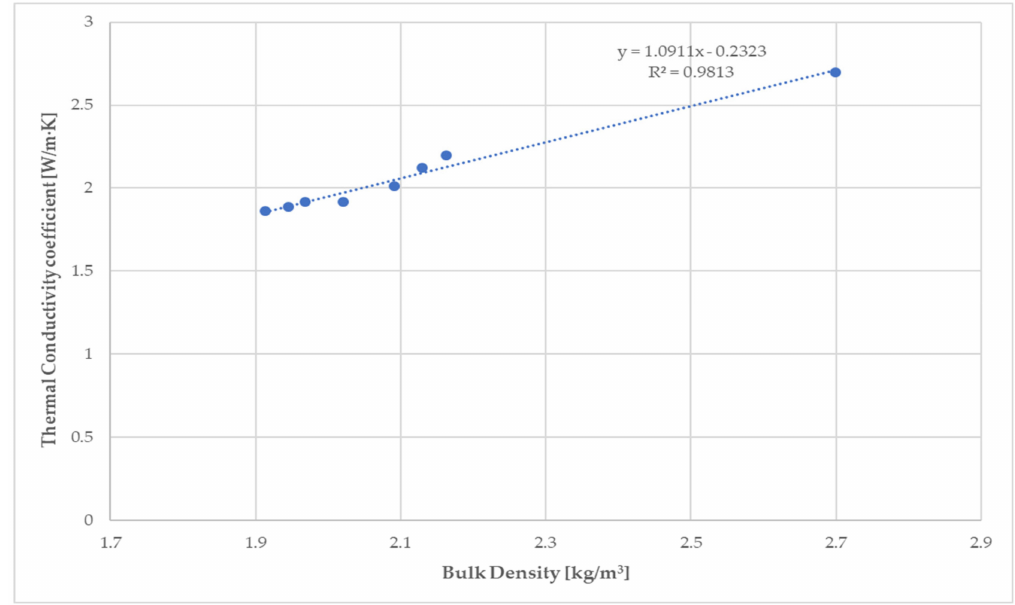
Figure 12. Relationship between the thermal conductivity coefficient and bulk density of 28-day fiber-cement mortar sample C with different C/WPF